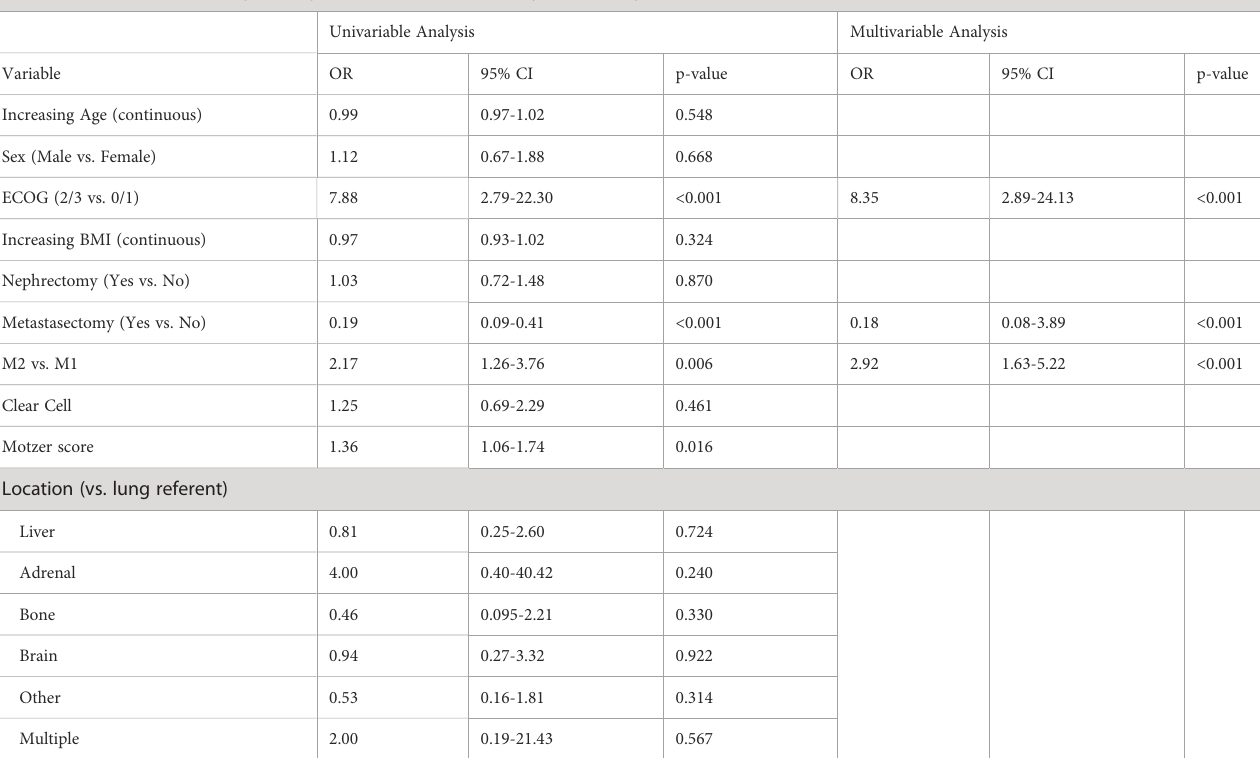
TABLE 3C Univariable and logistic regression multivariable analyses for